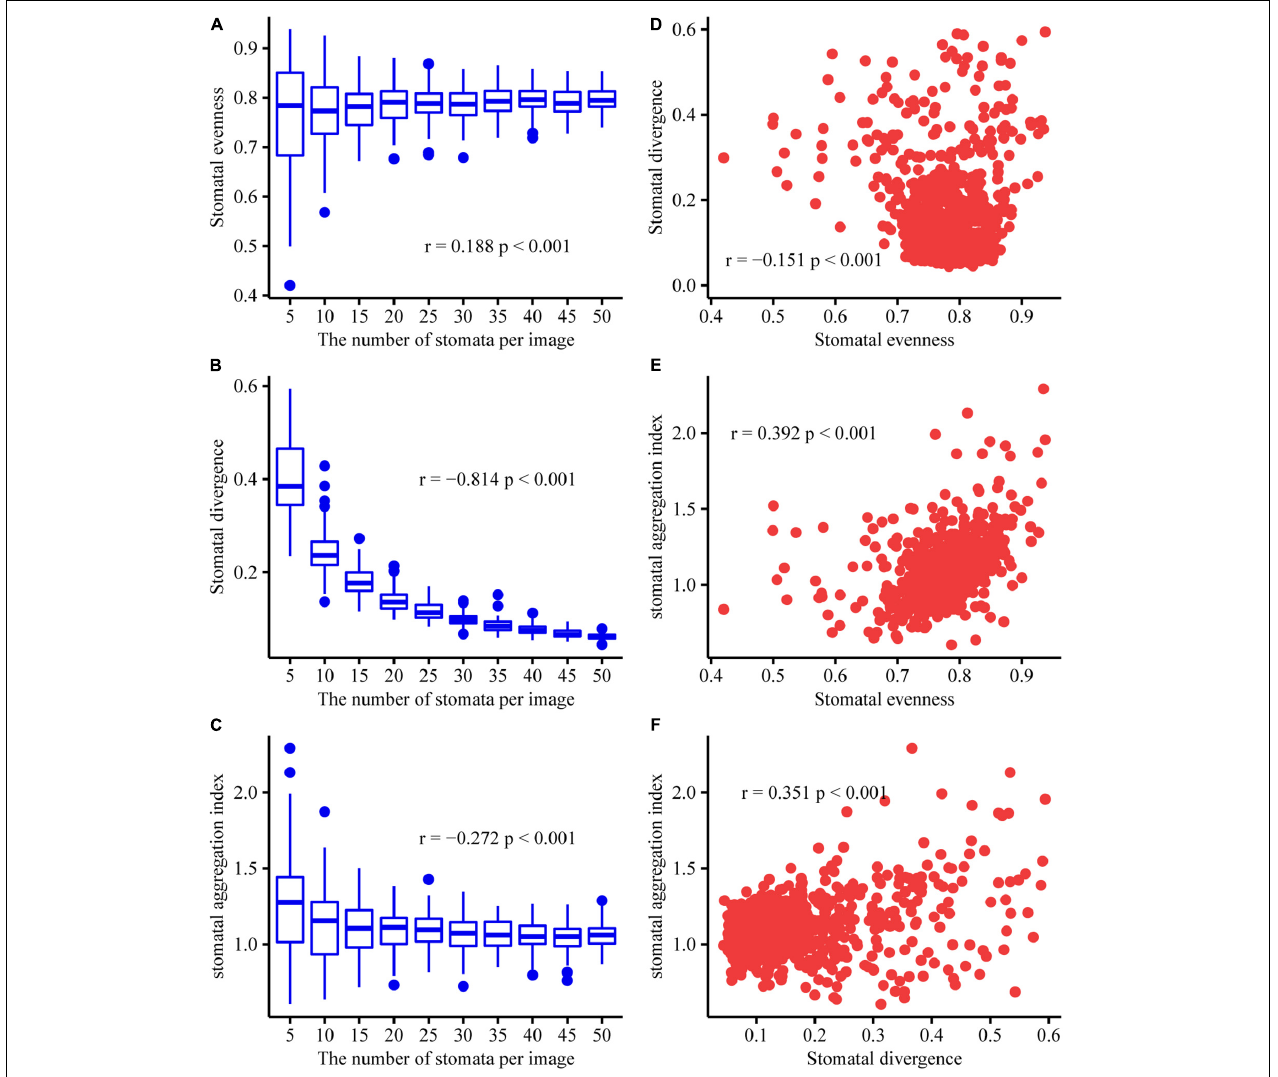
FIGURE 2 | Relationships between stomatal density, stomatal evenness, stomatal divergence, and stomatal aggregation. Here, we used the number of stomata per image as a proxy for stomatal density. Pearson’s correlation coefficients (r) and the significance levels (p) are given in each subfigure. The data is randomly generated, and code is available in the Supplementary Information . (A) Correlation between stomatal density and stomatal evenness. (B) Correlation between stomatal density and stomatal divergence. (C) Correlation between stomatal density and stomatal aggregation. (D) Correlation between stomatal evenness and stomatal divergence. (E) Correlation between stomatal evenness and stomatal aggregation. (F) Correlation between stomatal divergence and stomatal aggregation. At the same stomatal density, the distributions of stomatal evenness, stomatal divergence, and stomatal aggregation were shown in Panel (A–C) , respectively.